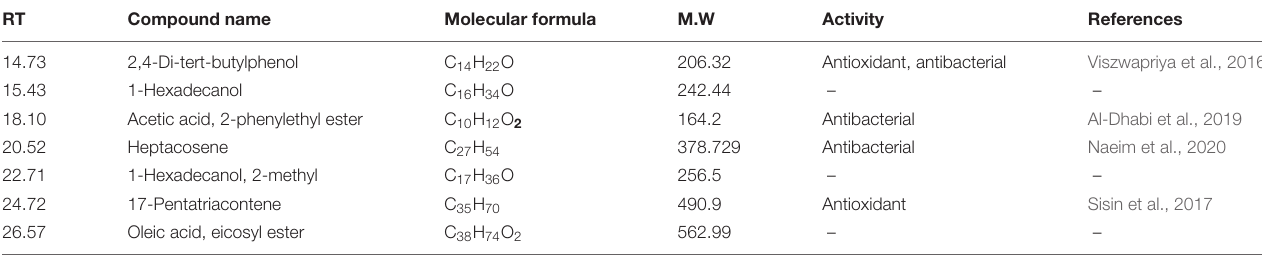
TABLE 4 | Common compounds that were found in the fungal crude extract after treatment.